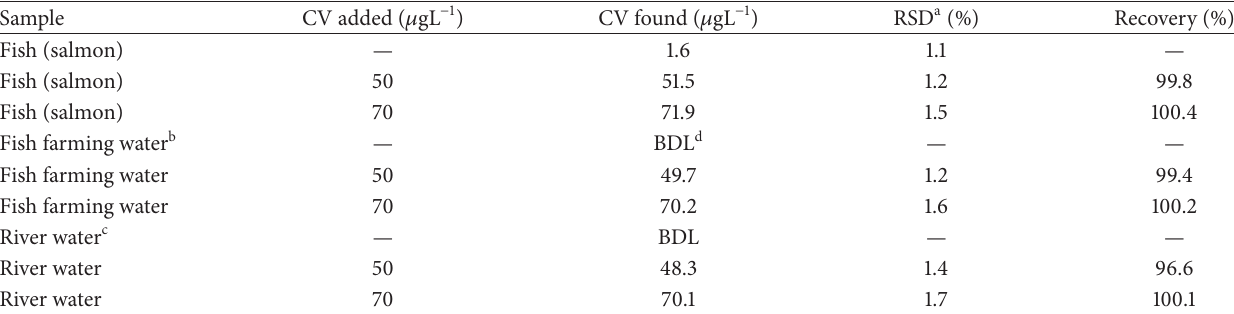
Table 2: Determination of crystal violet in different samples.